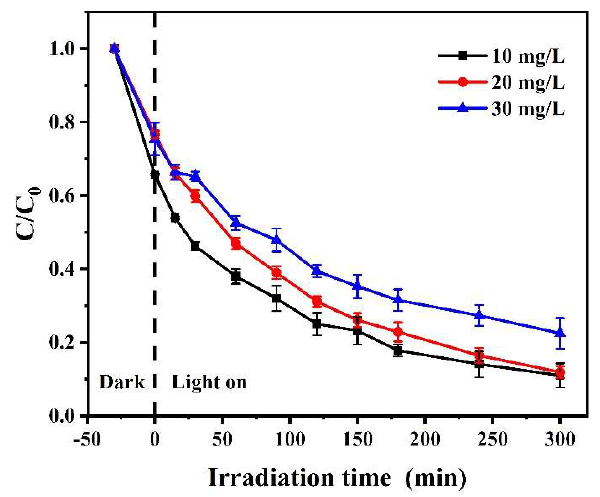
Figure 6. Effect of initial MB concentration on photocatalytic degradation efficiency.